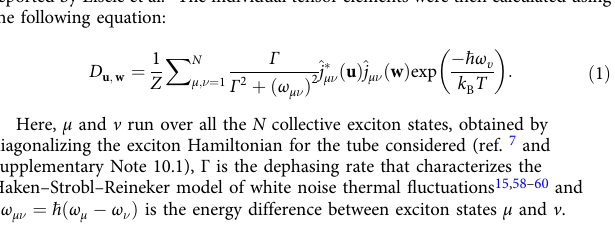
Fig. 7 Molecular grid for Monte Carlo simulations. The inner and outer tube are depicted as planes shaded in red and gray, respectively. Excitons are shown as orange circles with their size corresponding to the annihilation radius. The different processes that excitons can undergo during the MC simulations are exemplarily shown. For simulations of the exciton dynamics of the isolated inner tubes, only the bottom plane